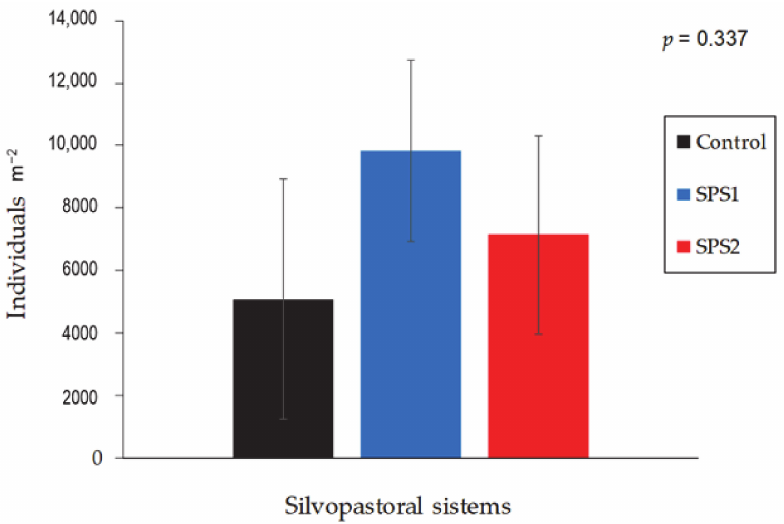
Figure 5. Soil macrofauna (individuals m − 2 ) found in the different silvopastoral systems with guinea grass Panicum maximum cv.